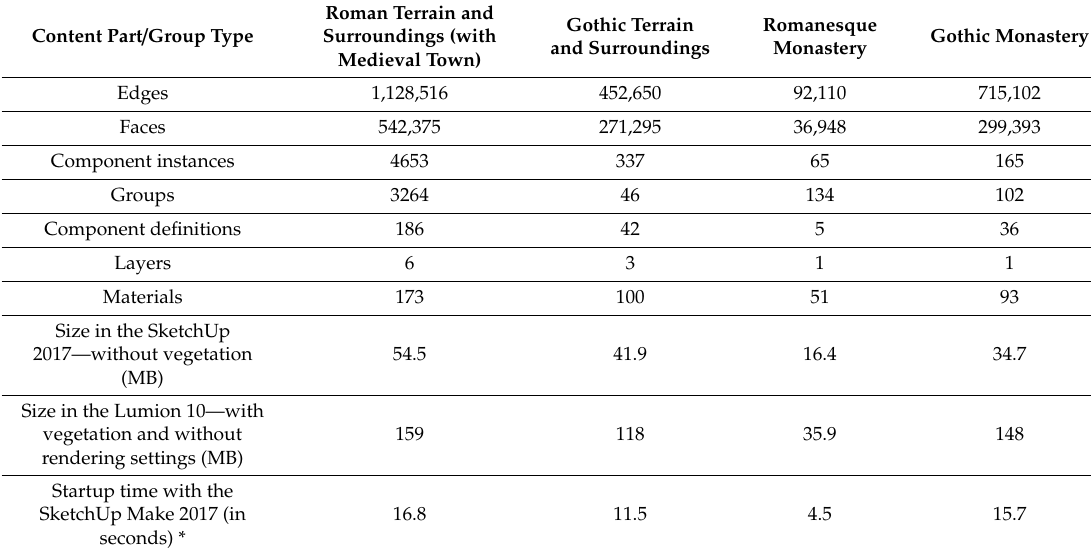
Table 3. Models of exteriors—an overview of components.